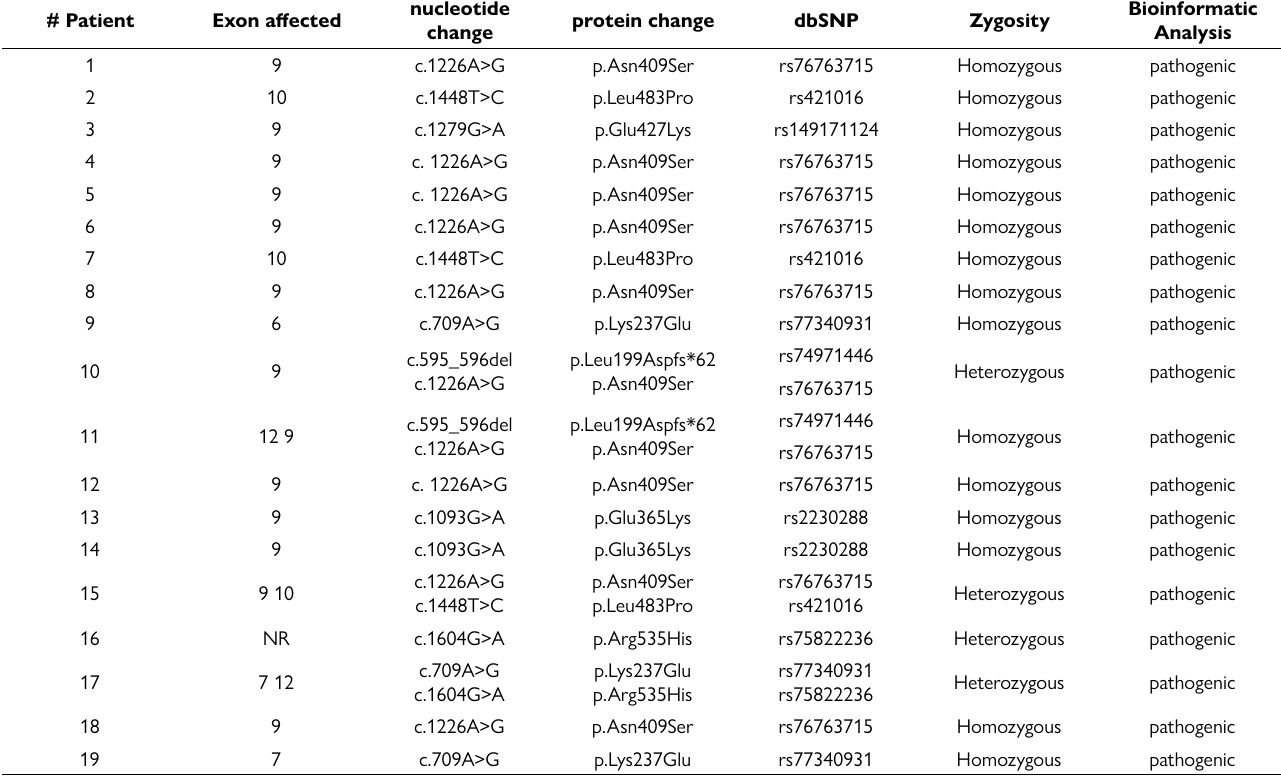
Table 2. Molecular characterization of the variants in the GBA gene found in 19 patients affected with Gaucher